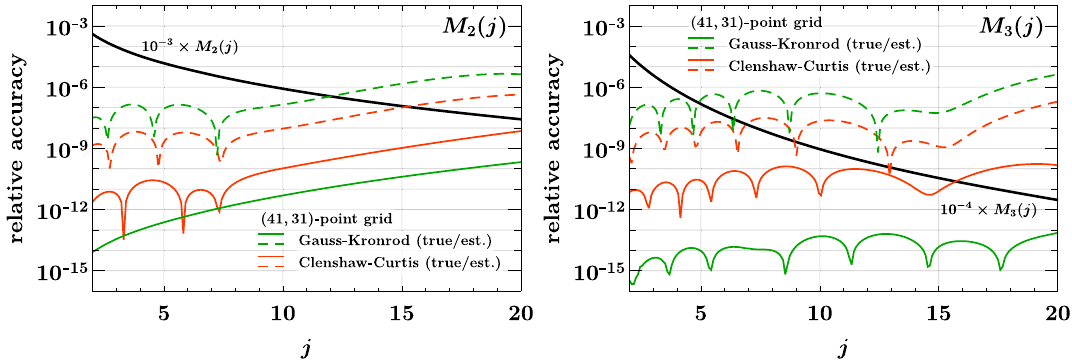
Chebyshev or Gauss–Kronrod points for the integration variable ln x . In the accuracy estimates, the results for a given integration rule are first added for the two subintervals, and then the absolute difference between the involved higher-order and lower-order rules is